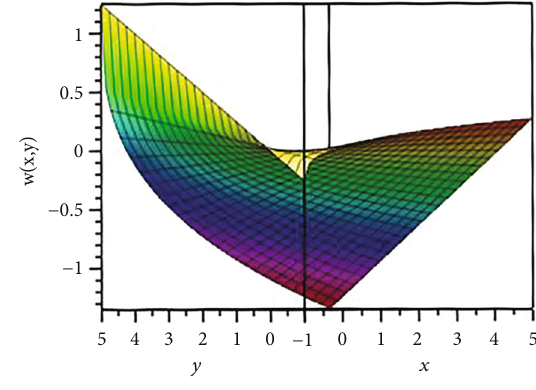
Figure 12: 3D complex plot of (50) for α = 1 .